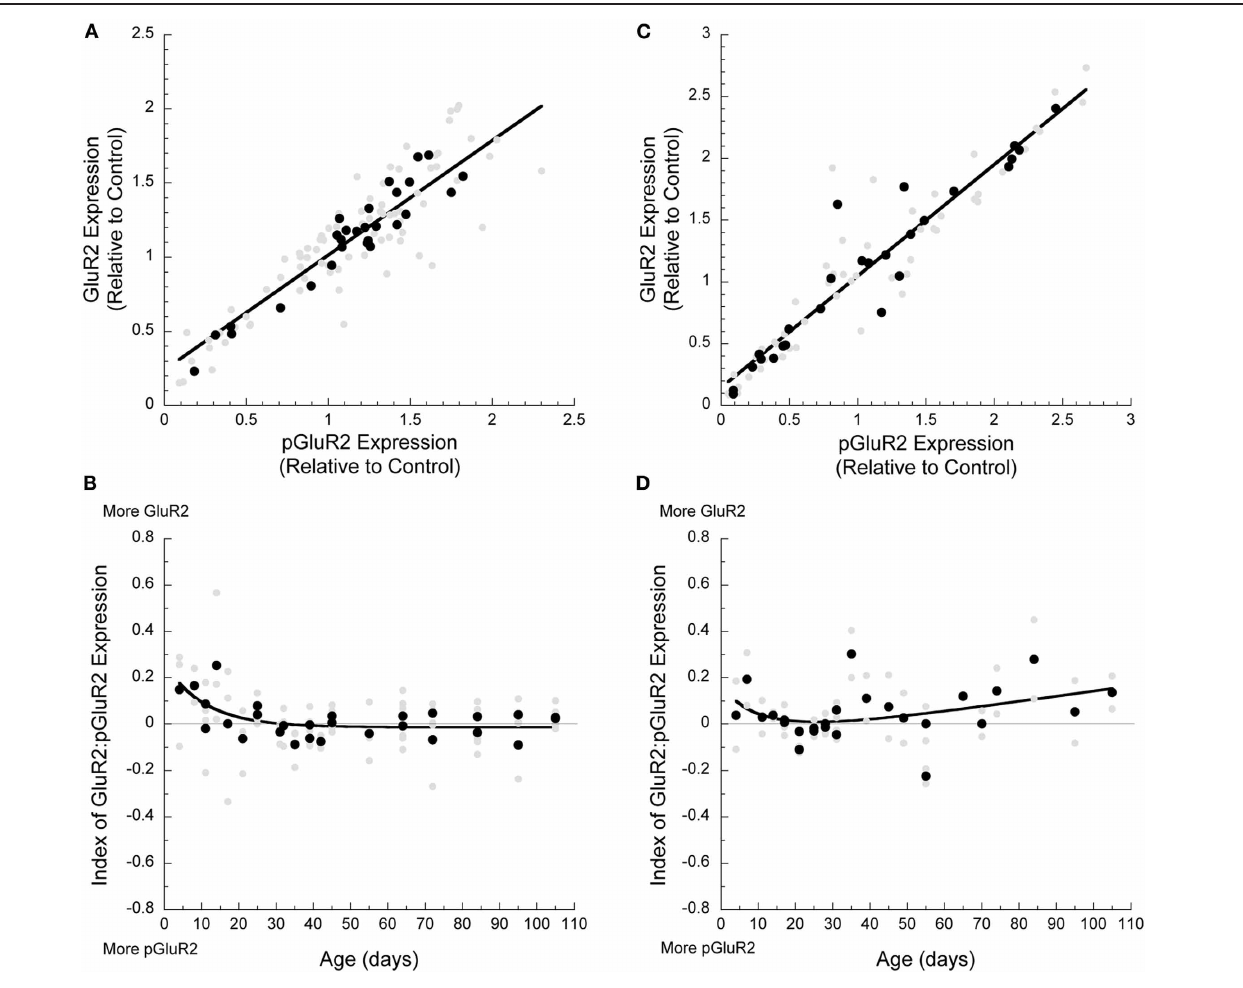
higher GluA2 expression initially, but a balance was reached by P33 (3 τ , R 2 = 0 . 37, p < 0 . 0005). (D) In frontal cortex, the index remained in favor of relatively more GluA2 throughout development, except for a brief period of balance between P18 and P30 (membrane transport curve, R 2 = 0 . 30, p = 0 .